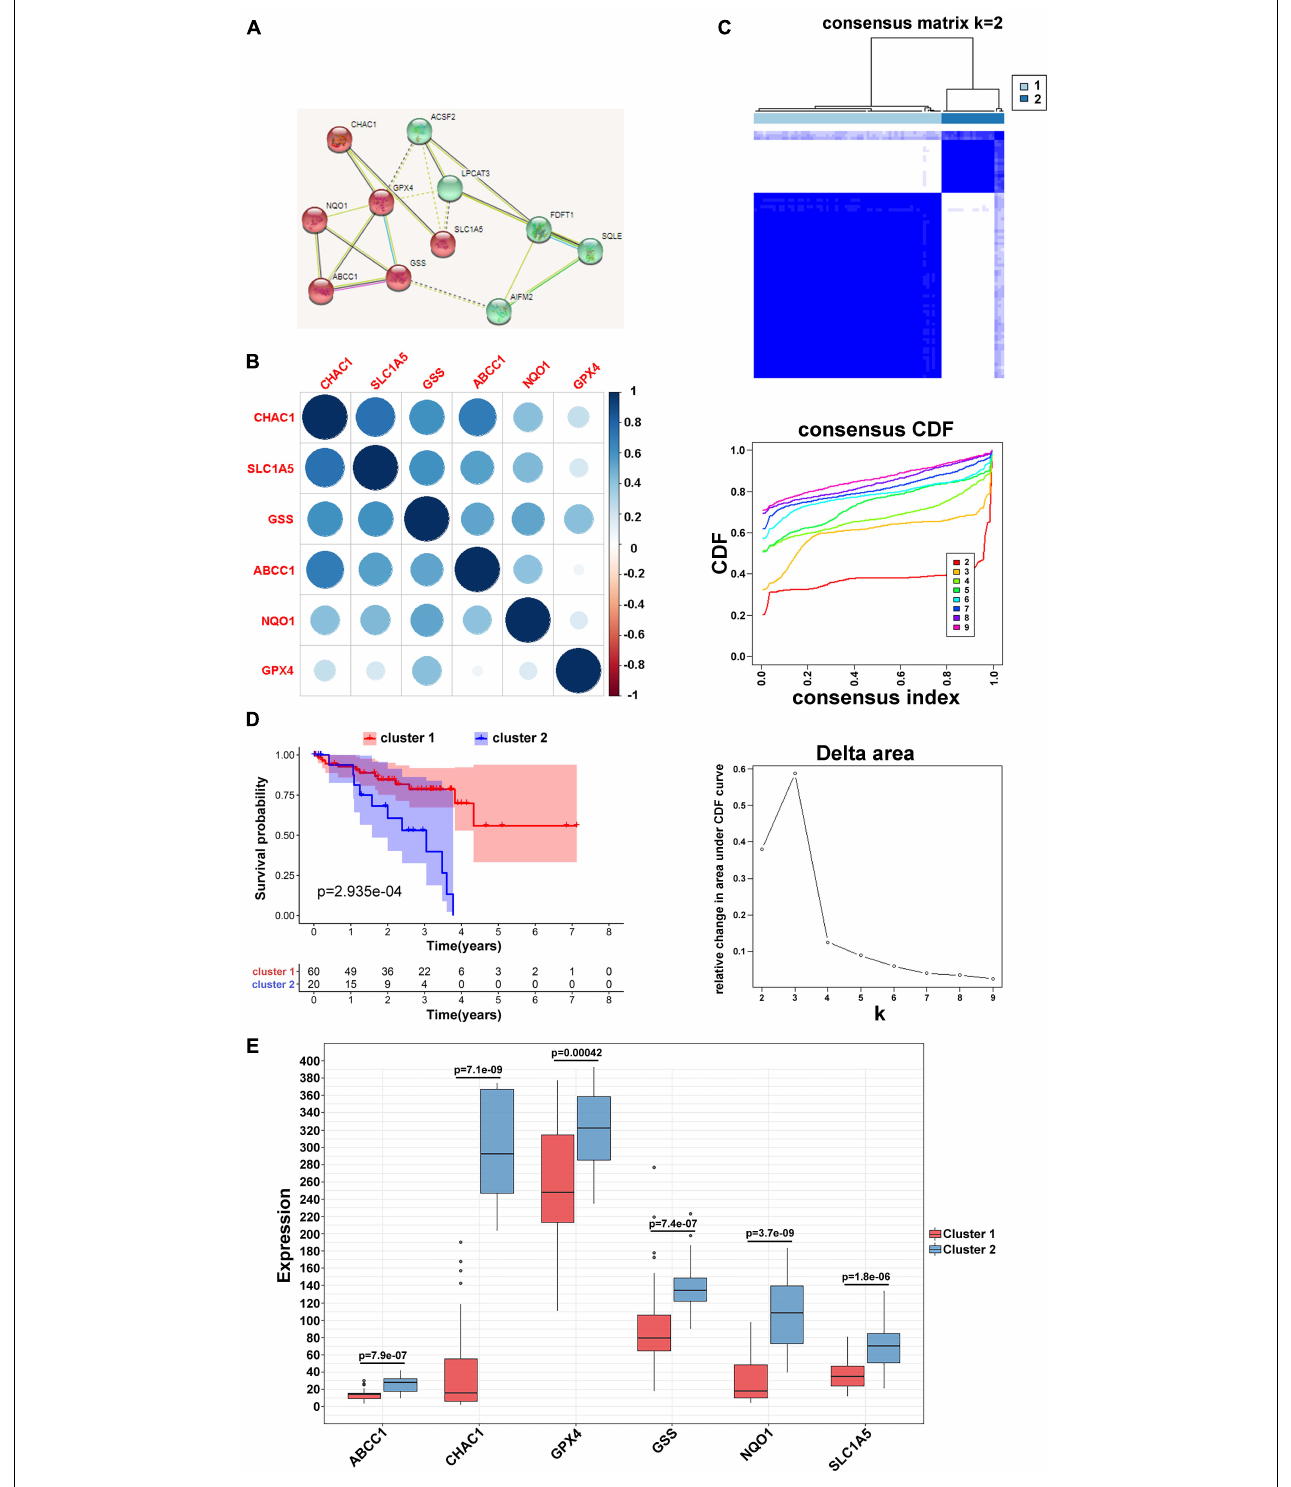
FIGURE 2 | Clustering of ferroptosis-related genes. (A) MCL clustering of ferroptosis-related genes. (B) Pearson correlation analysis among ferroptosis-related regulators in module A. (C) Consensus clustering cumulative distribution function (CDF) and relative change in area under CDF curve for k = 2 in module A. (D) Kaplan–Meier curves of two clusters in UVM about OS in module A. (E) The different expression of the ferroptosis-related mediators in two clusters based on module A.